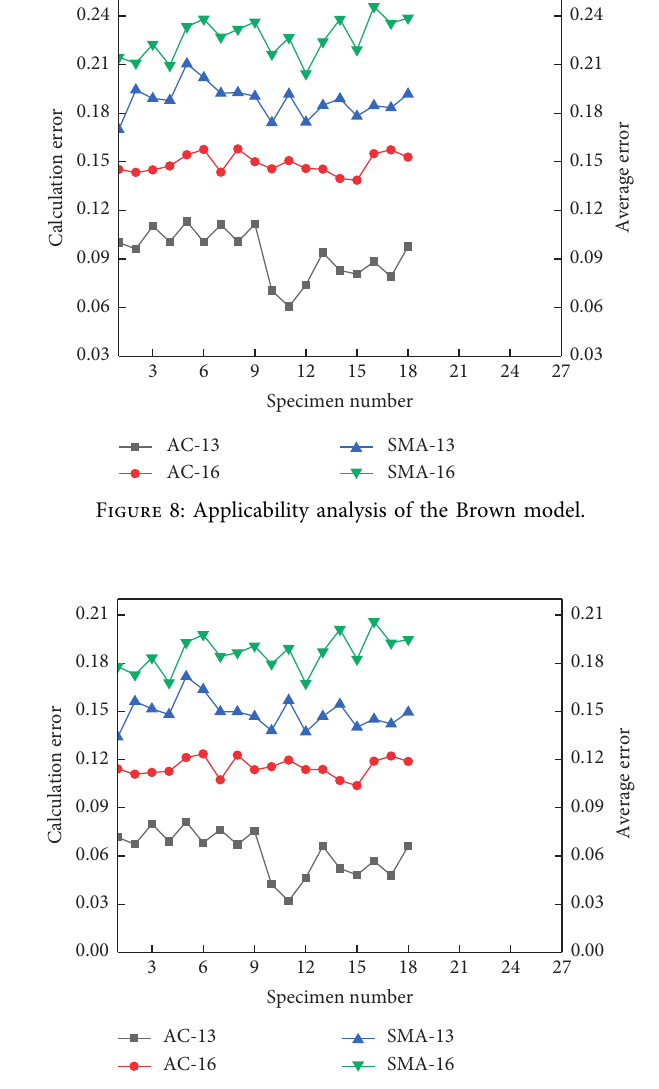
Figure 9: Applicability analysis of the CRIM model.